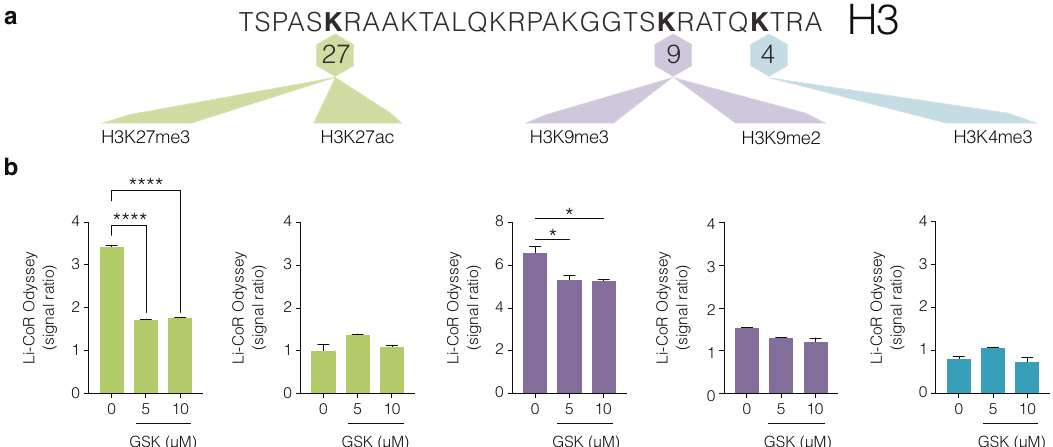
Fig. 3 Pharmacological inhibition of EZH2 activity by GSK126 diminishes H3K27me3 and not H3K27ac protein content in human pancreatic ductal cells. a Partial histone H3 lysine map of sites for methylation and acetylation. The transcriptionally suppressive marks, H3K27me3, H3K9me3 and H3K9me2 including permissive histone marks, H3K27ac and H3K4me3 are shown. b Dose-dependent increase of GSK126 (5 or 10 µM) for 48 h attenuates H3K27me3 in human pancreatic ductal cells. Histones and their associated proteins were prepared by acid extraction. Quanti fi cation levels of H3K27me3, H3K27ac, H3K9me2, H3K9me3 and H3K4me3 were calculated and adjusted to overall histone H3 using Li-COR Odyssey. The signal ratio calculated was as follows; H3K27me3/total H3, H3K27ac/total H3, H3K9me3/total H3, H3K9me2/total H3, and H3K4me3/total H3. Vehicle control is DMSO. Ordinary one-way ANOVA was performed on Control vs GSK-126 (* P < 0.05, **** P < 0.0001 error bars are SEM, n =